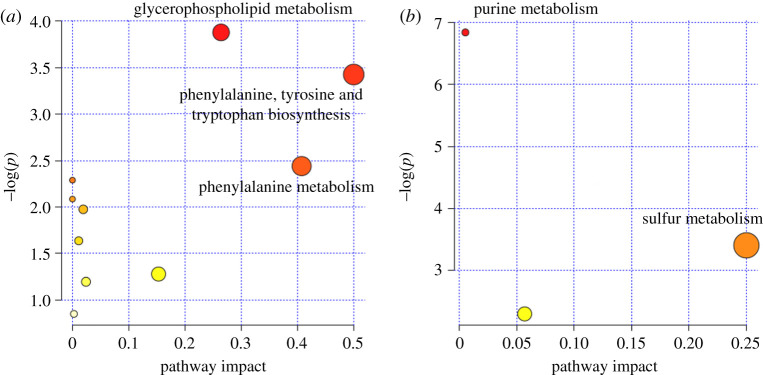
Enrichment of metabolic pathways based on differentially expressed metabolites. (a) Positive ion mode; (b) negative ion mode. All matched pathways are depicted based on –log(p) value from pathway enrichment analysis and pathway impact score from pathway topology analysis. Colour gradient indicates the significance of the pathway ranked by –log(p) value (red: higher –log(p) values and yellow: lower –log(p) values). Circle size indicates pathway impact score (the larger the circle the higher the influence score).